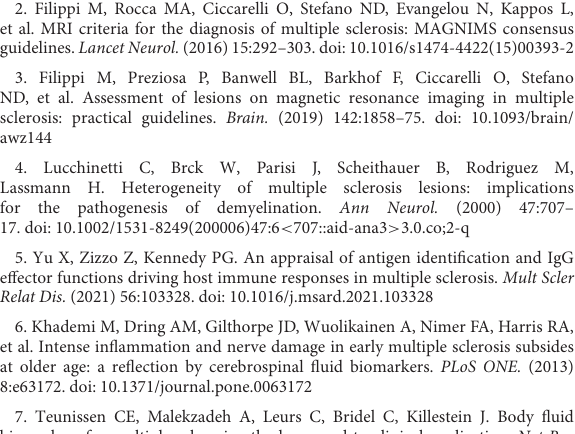
SUPPLEMENTARYFIGURE3 Correlation of CSF inflammatory parameters with disease duration at sample collection. Scatterplot graphs of the linear regression analysis showed the relation between cytokine/chemokine levels in CSF and DD at sample collection. Strengths of the associations are given in R 2 values. The DD was defined as the term (year) from first episode with neurological deficit to sample collection. CSF, cerebrospinal fluid; MS, multiple sclerosis; NMOSD, neuromyelitis optica spectrum disorder; DD, disease duration. SUPPLEMENTARYFIGURE4 Correlation of CSF inflammatory parameters with duration of acute exacerbation at sample collection. Scatterplot graphs of the linear regression analysis showed the relation between cytokine/chemokine levels in CSF and ADD at sample collection. Strengths of the associations are given in R 2 values. The ADD was defined as the term (day) from onset of acute neurological deficit to sample collection. CSF, cerebrospinal fluid; MS, multiple sclerosis; NMOSD, neuromyelitis optica spectrum disorder; ADD, acute disease